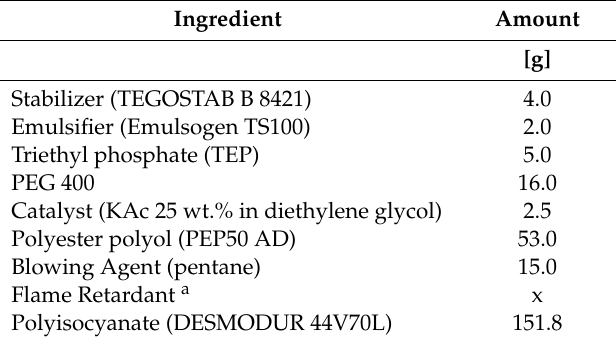
Table 2. Formulation of the polyisocyanurate (PIR) foams